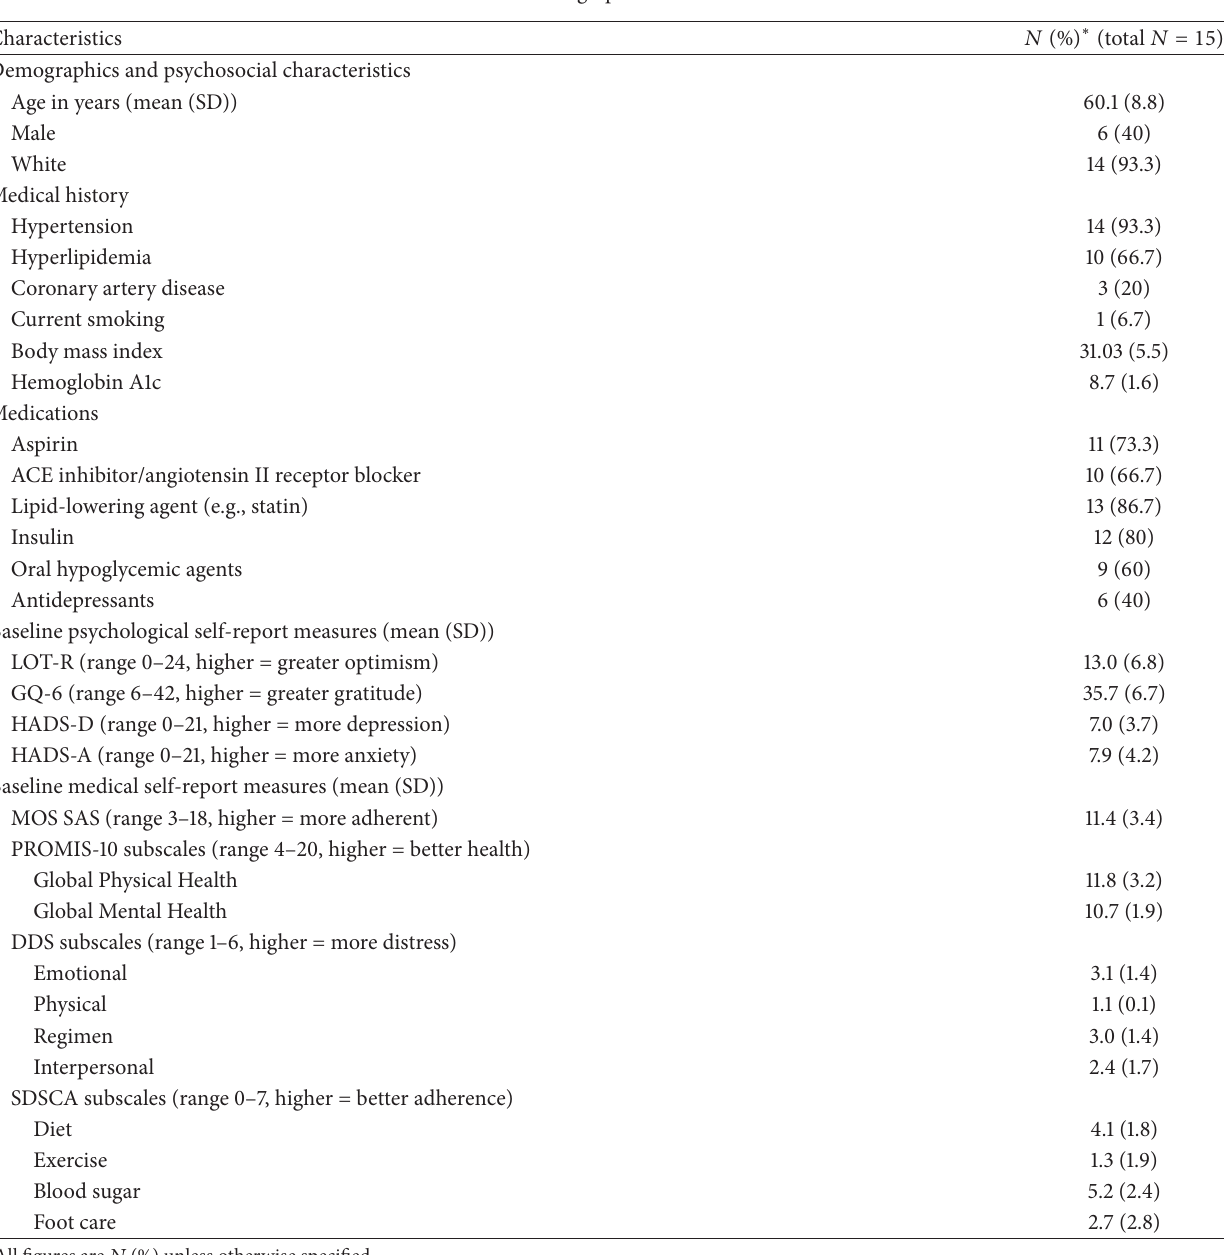
Table 2: Baseline sociodemographic and clinical